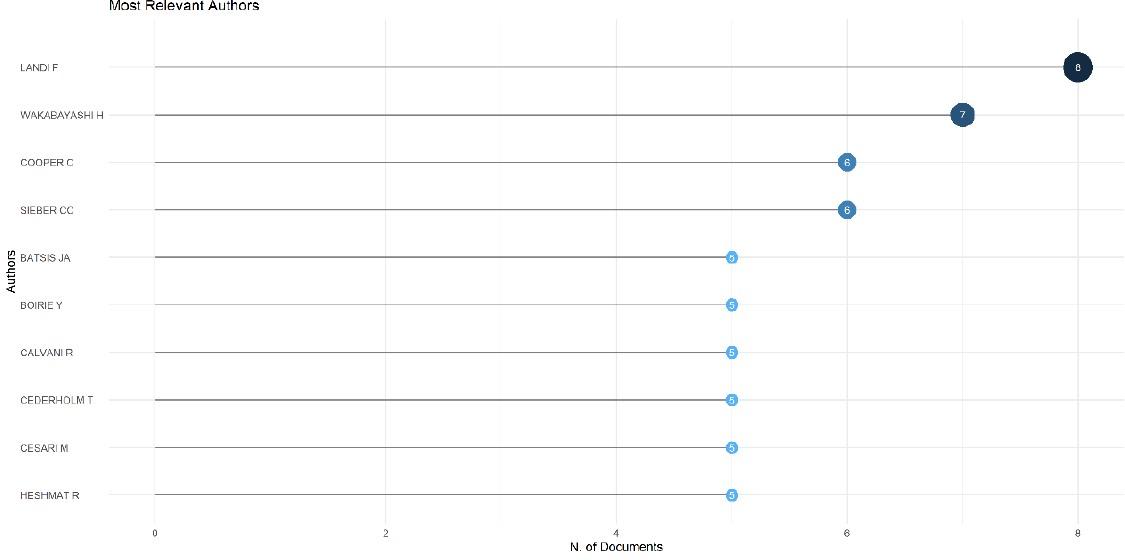
Figure 5. Top 10 authors that produced nutrition research works on sarcopenia.